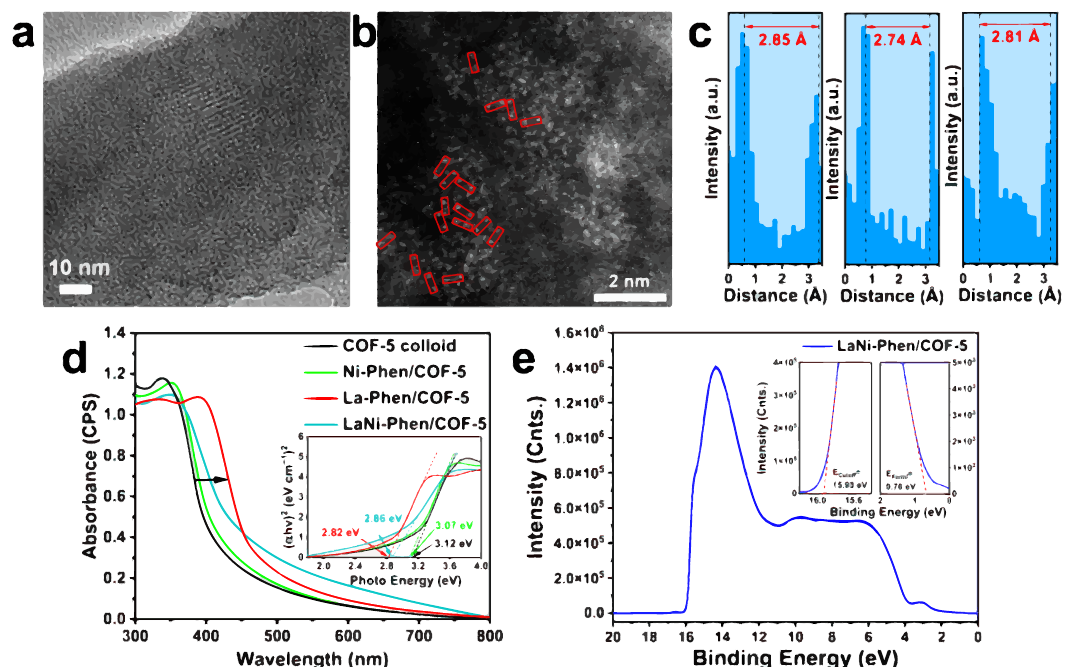
Fig. 2 | Visualization and spectroscopic characterization of LaNi-Phen/COF-5. a HR-TEM image, b atomic-resolution HAADF-STEM images of LaNi-Phen/COF-5. c measured distance of the representative La-Ni sites in panel b . d UV-vis diffuse